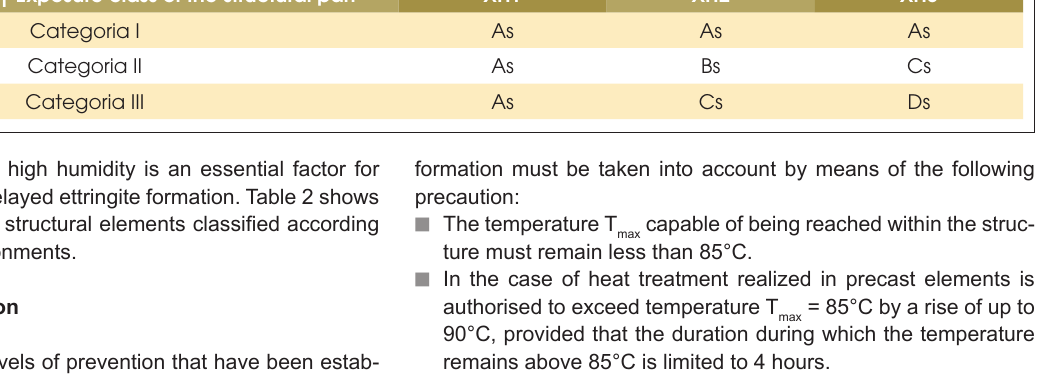
Table 3 – Choice of level of prevention (Adapted from LCPC [7]) Structure category | Exposure class of the structural part